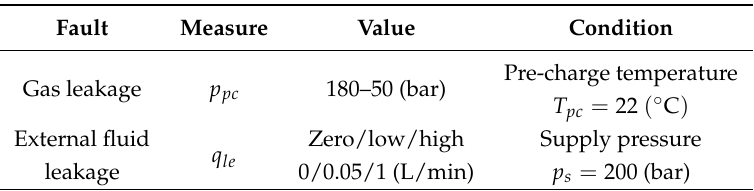
Table 2. Main data for the considered